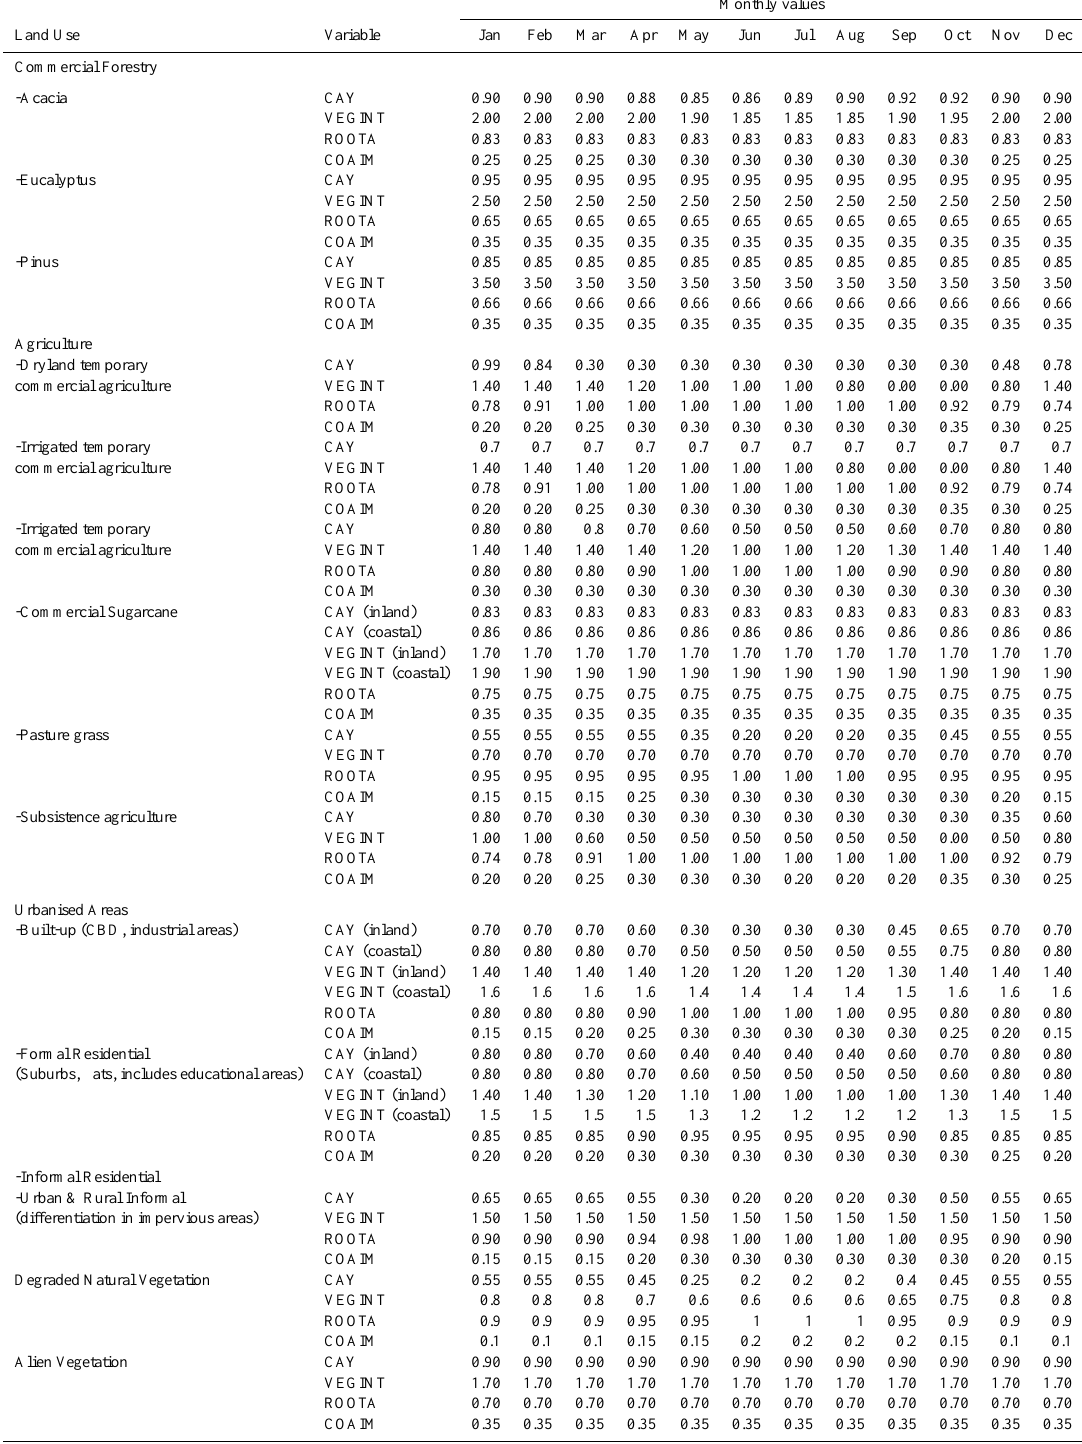
Table 1. Monthly values of water use coefficients, canopy interception per rainday, root mass distribution in the topsoil, coefficient of initial abstractions and index of suppression of soil water evaporation by a litter/mulch layer, for the land uses occurring in the Mgeni, Luvuvhu and Upper Breede catchment (Schulze,